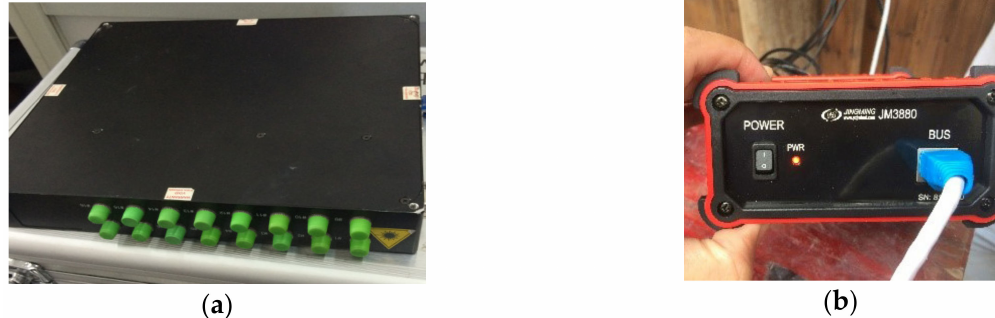
Figure 5. Signal demodulators: ( a ) Fiber grating demodulator; ( b ) Yangzhou Jingming Static Data Acquisition